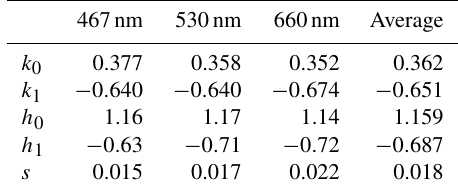
Table 1. The values of the constants used in the Virkkula (2010) correction scheme (Virkkula,